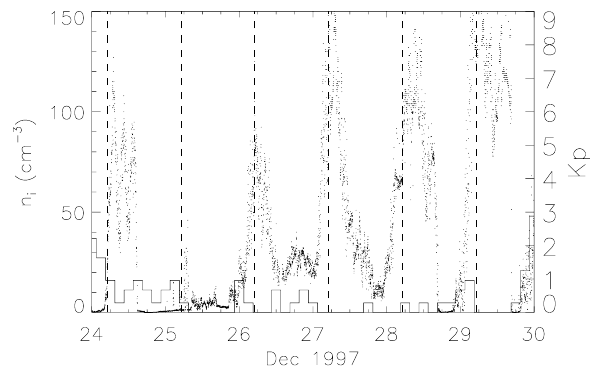
Fig. 1. Density measured by satellite 1994-084 for six days in De- cember 1997, and K p for the same time period. This particular satellite passed through local noon at approximately 05:00UT each day, and these times are marked with the vertical dashed lines.